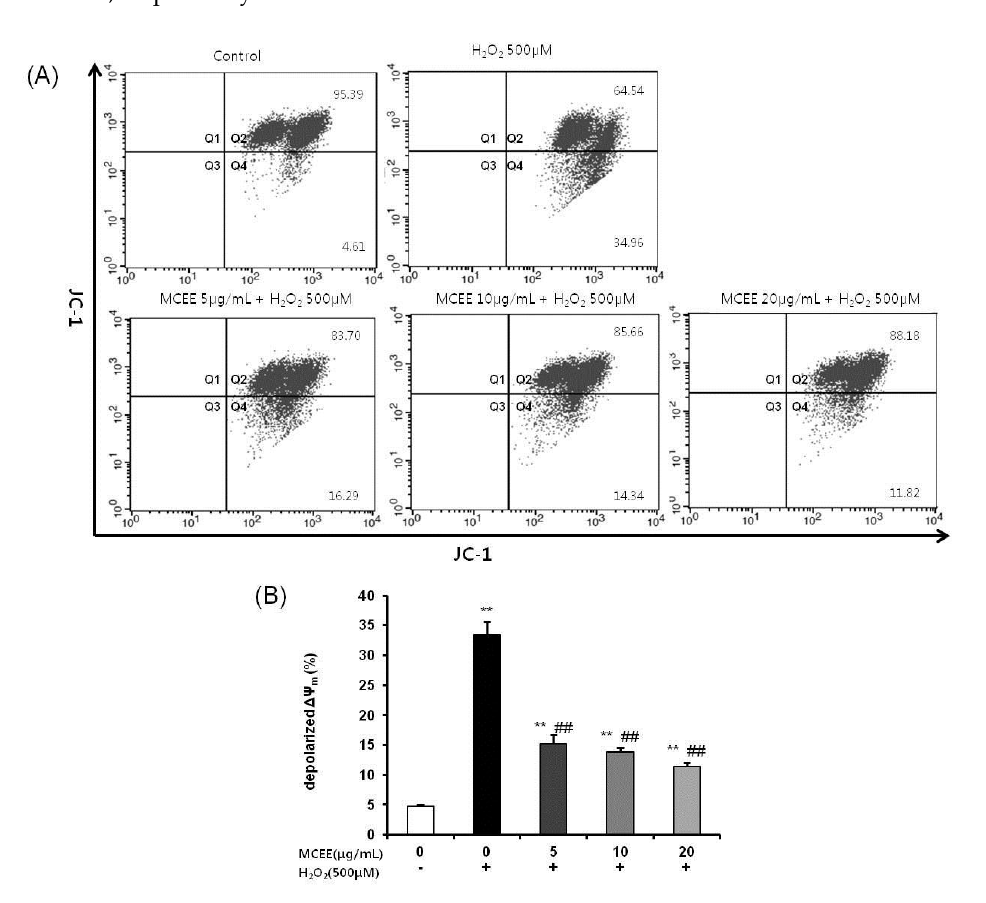
Figure 6. Effect of MCEE on the mitochondrial membrane potential (ΔΨ m ) in SK-N-MC cells. Cells were pretreated with MCEE for 24 h and then treated with H 2 O 2 for 4 h. JC-1 staining was analyzed by flow cytometry. ΔΨ m was measured using JC-1 fluorescence dye by a flow cytometer. ( A ) Quadrant analysis of the fluorescence characteristics of four panels: Q2, red fluorescence +/green fluorescence +, polarized ΔΨ m ; Q4, red fluorescence –/green fluorescence +, depolarized ΔΨ m . ( B ) Quantitative analysis of the bar graphs showed the percentage of depolarized ΔΨ m . Data are shown as means ± S.D. ( n = 3). ** p < 0.01 compared with the untreated control cells, ## p < 0.01 compared with only H 2 O 2 -treated cells. JC-1, 5,5’,6,6’-tetrachloro-1,1’,3,3’-tetraethyl - enzimidazolcarbocyanine iodide.